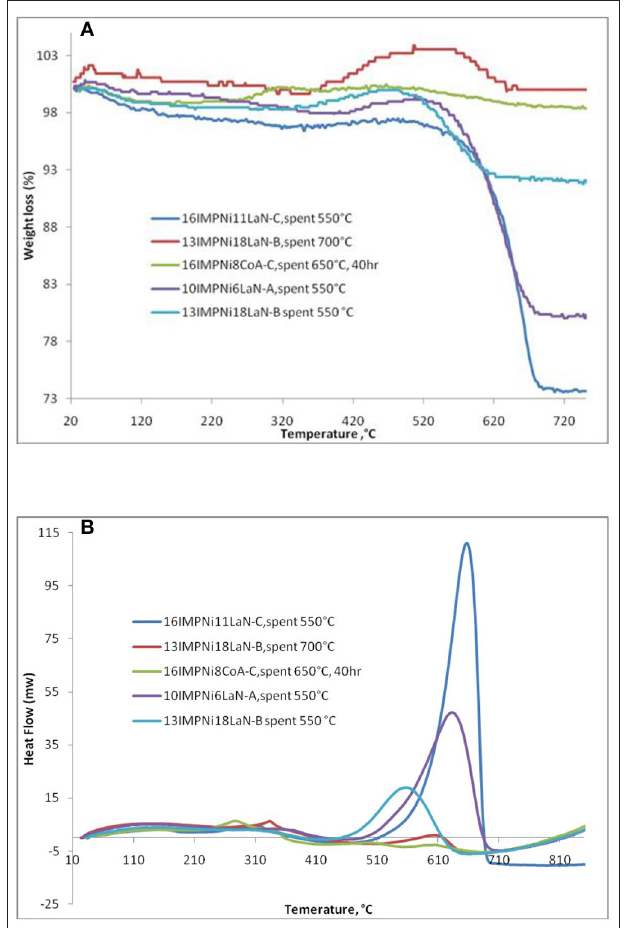
FIGURE 6 | TGA (A) /DSC (B) analysis of 10IMPNi6LaN-A, 13IMPNi18LaN-B, 16IMPNi11LaN-C, and 16IMPNi8CoA-C spent